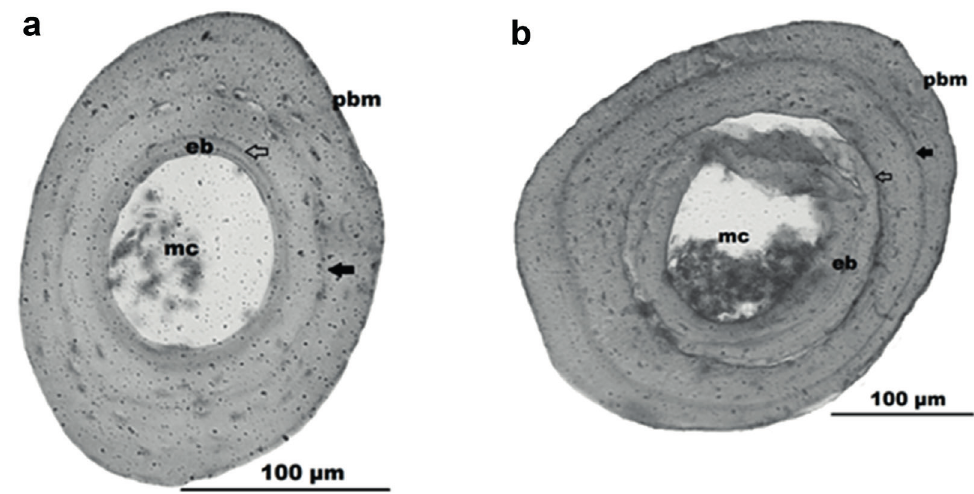
Figure 2 - Cross sections through a phalanx of Leptodactylus latinasus ( a ) and L. bufonius ( b ). An arrowhead indicates the lines of arrested growth (lAgs), medullar cavity (mc), endosteal bone (eb), periosteal bone margin (pbm).